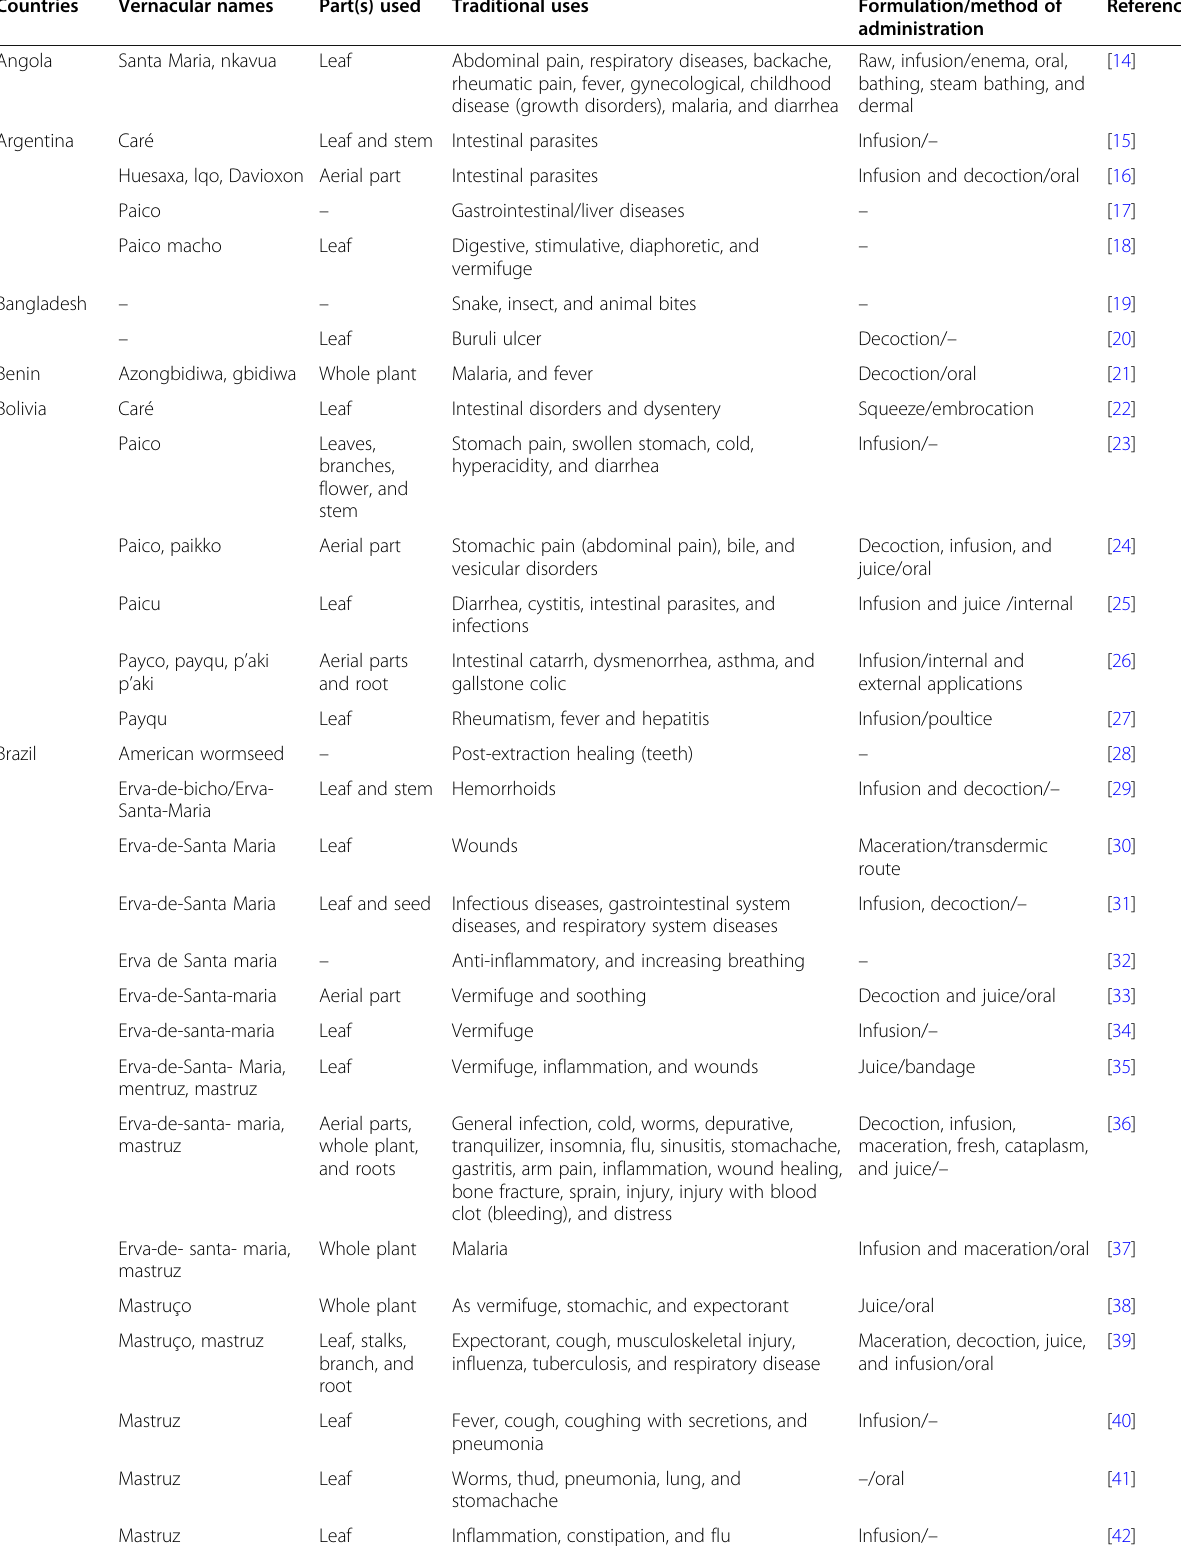
Table 1 Traditional uses of the different parts of C. ambrosioides worldwide